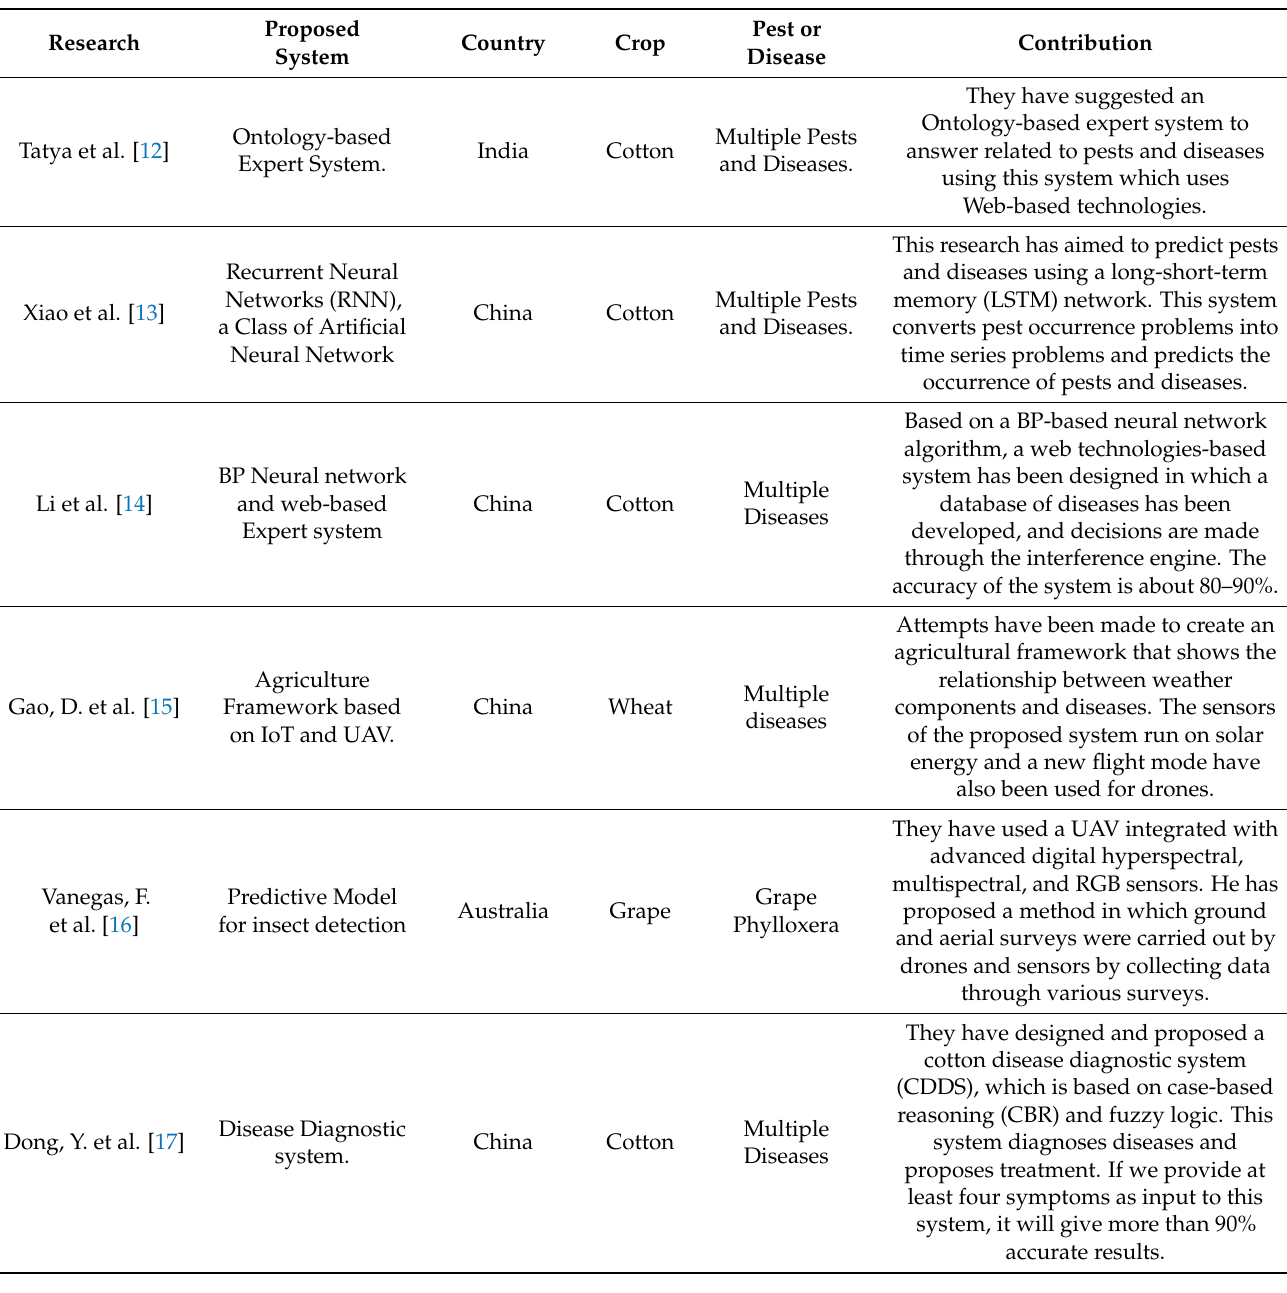
Table 1. Existing IoT frameworks and Models for Pest and Disease